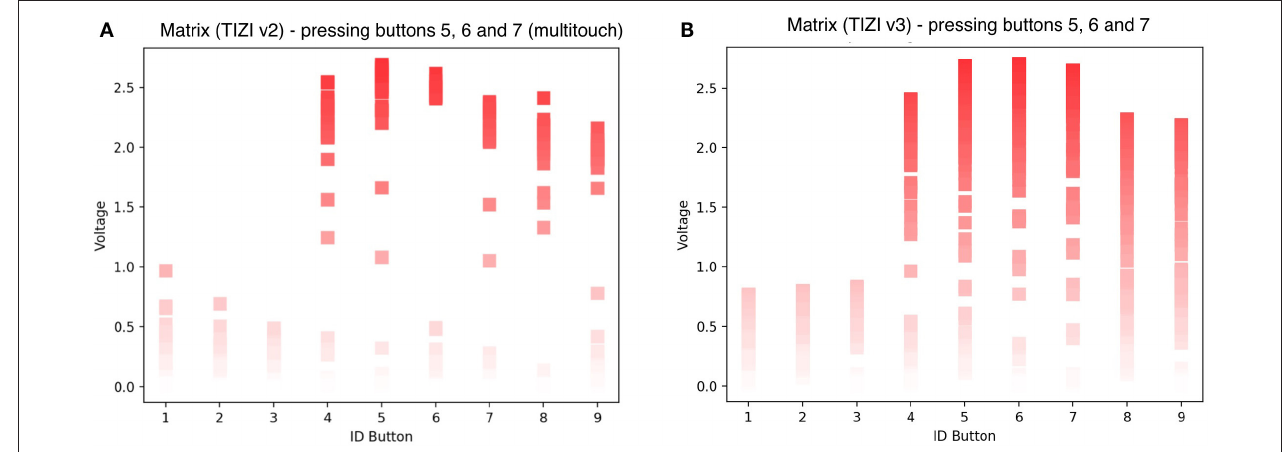
FIGURE 11 | Readings of the matrix with multitouch example; (A) TIZI v2 vs. (B) TIZI